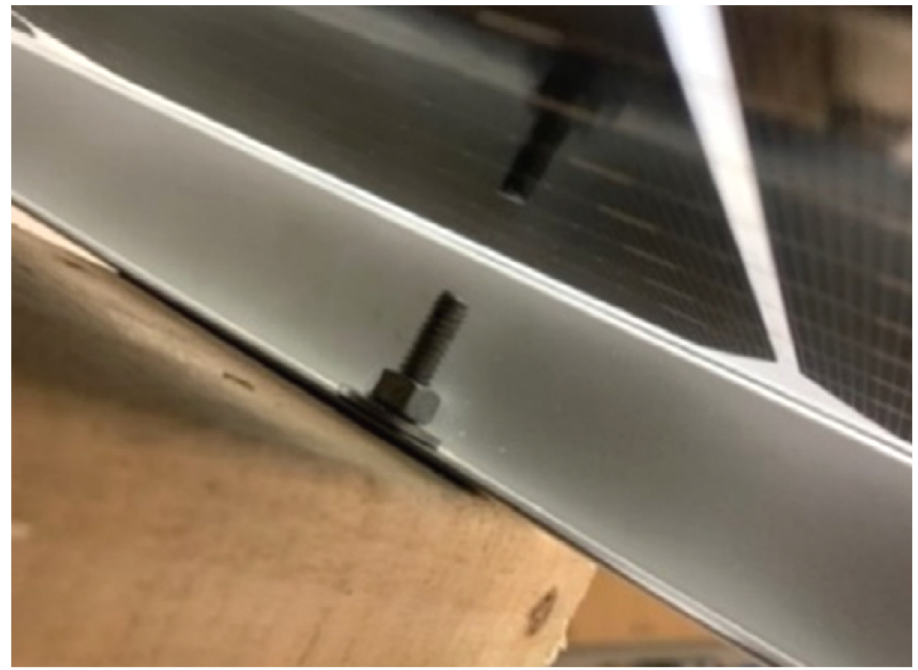
Figure 7. Simple standard steel bolts can be used to attach a conventional PV module to a wood frame. The reflection of the bolt is seen in the PV cell in the bifacial module above